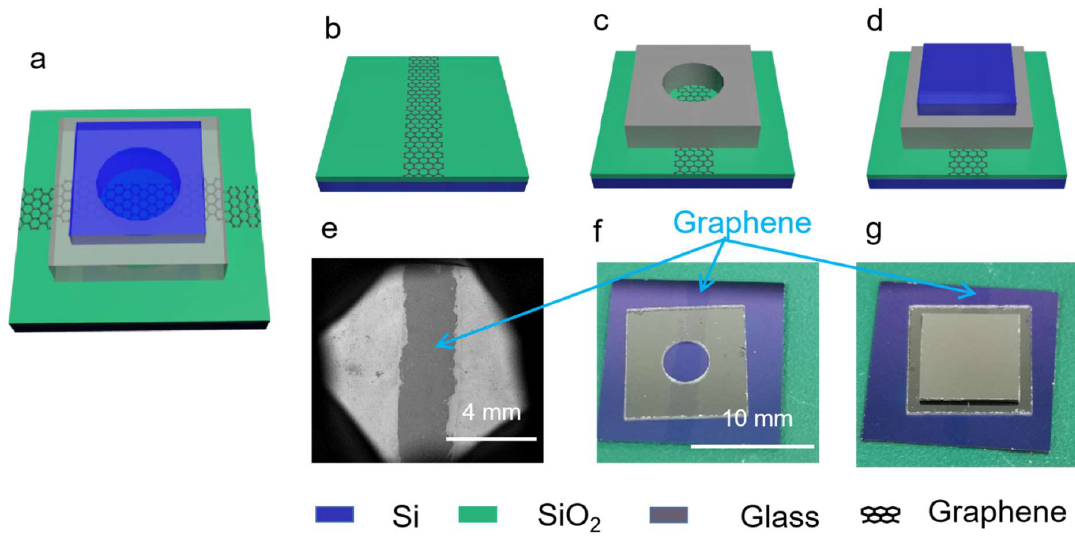
Figure 1. Device structure and fabrication processes. ( a ) Schematic structure of the device; ( b ) Transferring and patterning graphene; ( c ) Two-layer device after first anodic bonding; ( d ) Three-layer device after second anodic bonding; ( e ) An SEM image of the structure in ( b ); ( f ) A photograph of the structure in ( c ); ( g ) A photograph of the structure in ( d ). A 15 mm × 15 mm Si/SiO 2 (500 µ m/300 nm) chip was first treated by reactive